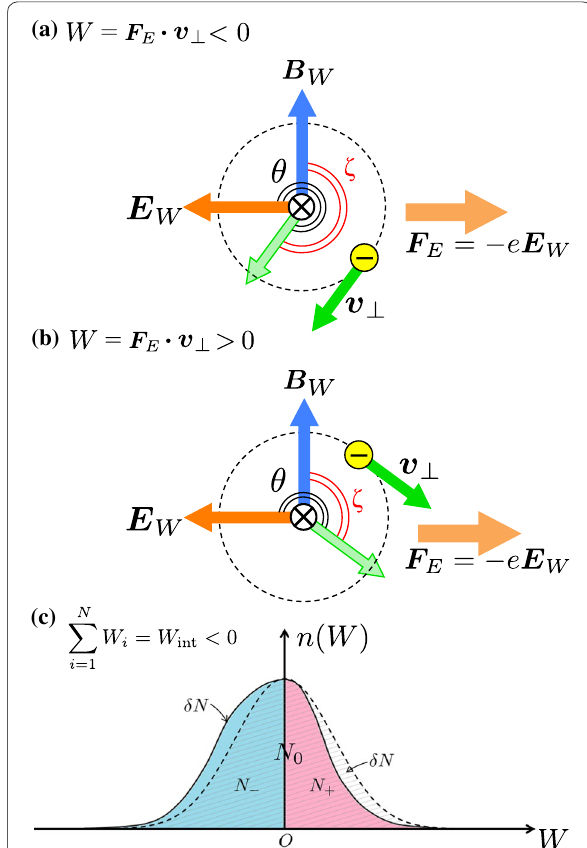
Fig. 1 Schematic diagram of the S-WPIA for measuring interactions between energetic electrons and whistler-mode waves propagating purely parallel to the background magnetic field (after Katoh et al. 2013). Panels a and b represent the relation between the perpen- dicular component of the velocity vector of an electron ( v wave electric ( E w ) and magnetic ( B w ) field vectors in the cases of a W < 0 and b W > 0. c Distribution of energetic electrons as a function of W , corresponding to a negative W int case representing wave genera- tion. The total number of energetic electrons is N 0 , while N W ,